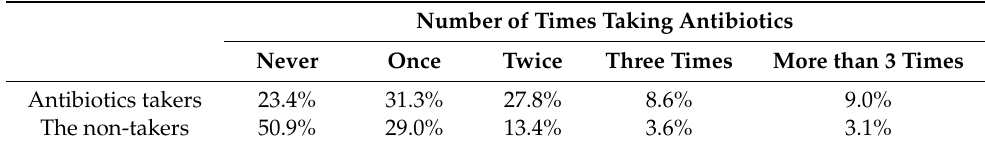
Table 5. Frequency of taking antibiotics by both groups in the past 12 months.